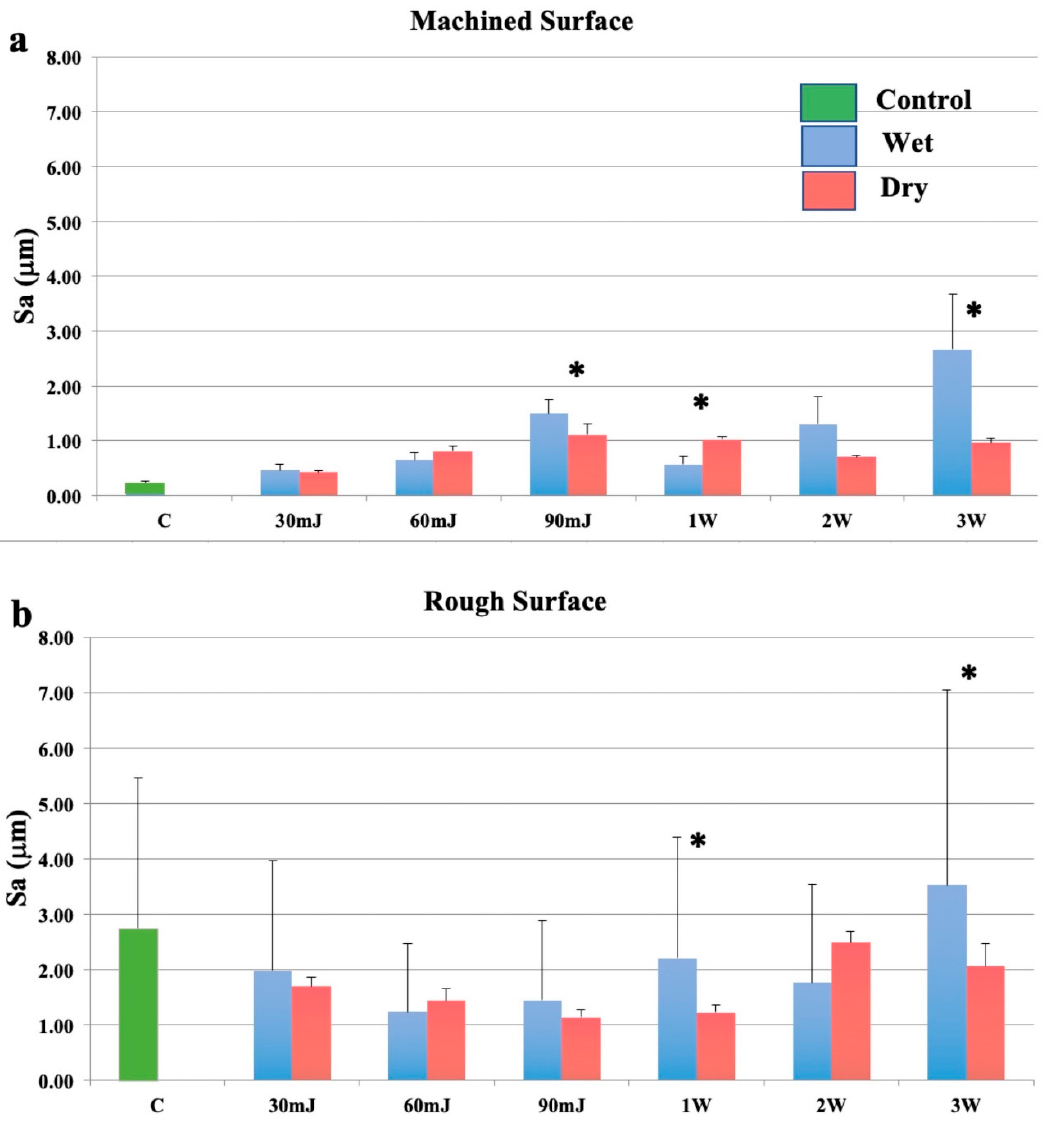
Figure 3. Effects of the neodymium: yttrium aluminium garnet (Nd:YAG) laser with a plain fibre tip. ( a ): Machined surfaces. ( b ): Roughened surfaces. Bars show controls (green), wet surfaces (blue), and dry surfaces (red). * indicates a significant difference between wet and dry conditions ( p < 0.05).